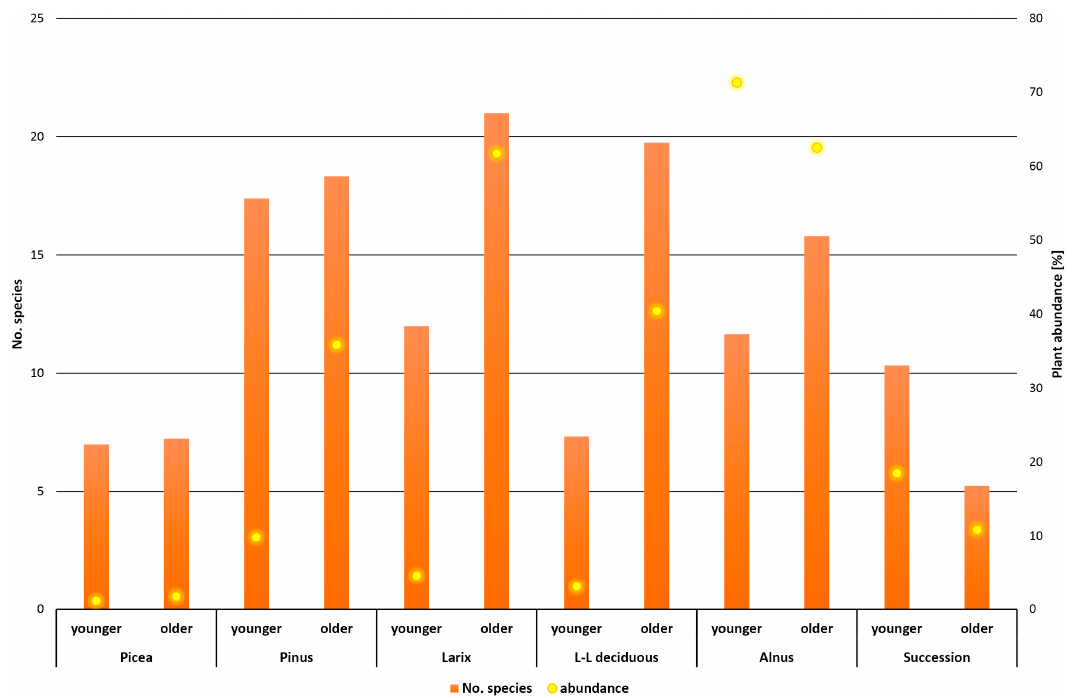
Figure 3. Raunkiær's life forms—distribution of functional groups in forest type and different ages. NF—nanophanerophyte, HF—hemicryptophyte, G—geophyte, T—therophyte, MF—macrophan- erophyte.